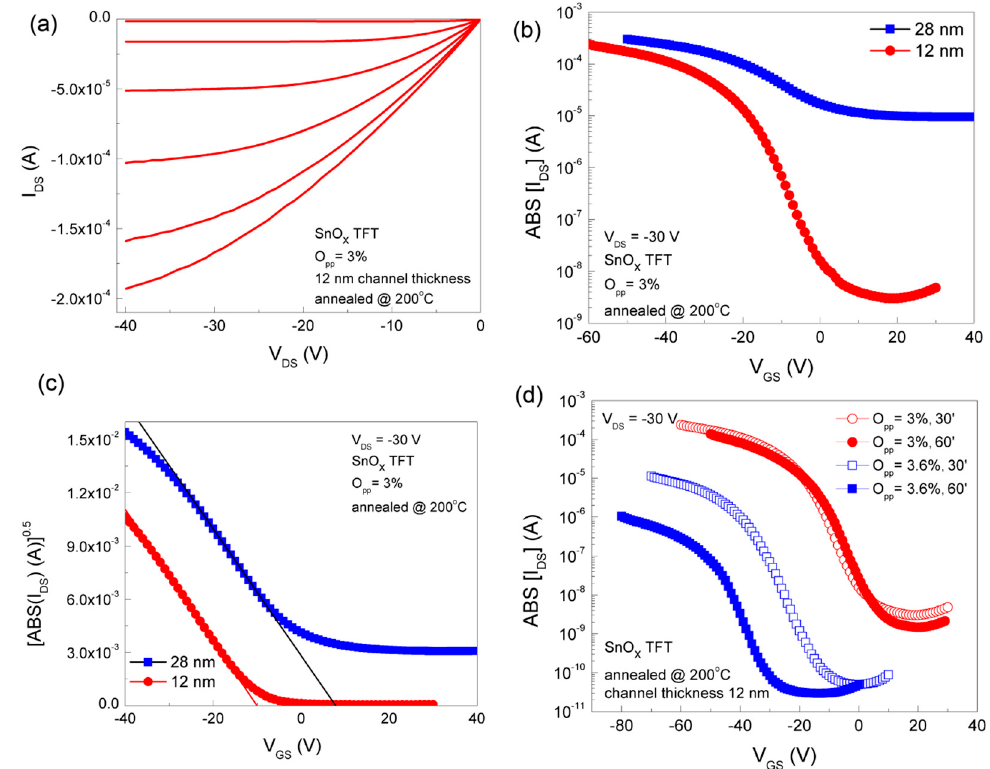
Figure 7. ( a ) Output characteristics of SnO x p-channel TFT. The gate voltage is varied from 0 V to − 50 V in − 10 V steps. ( b ) Transfer characteristics of SnO x p-channel TFT with different channel thickness. ( c ) Plot of square root of drain current, at V DS = − 30 V, for evaluating saturation mobility and threshold voltage. ( d ) Transfer characteristics of SnO x p-channel TFT (channel thickness 12 nm) for different annealing time.